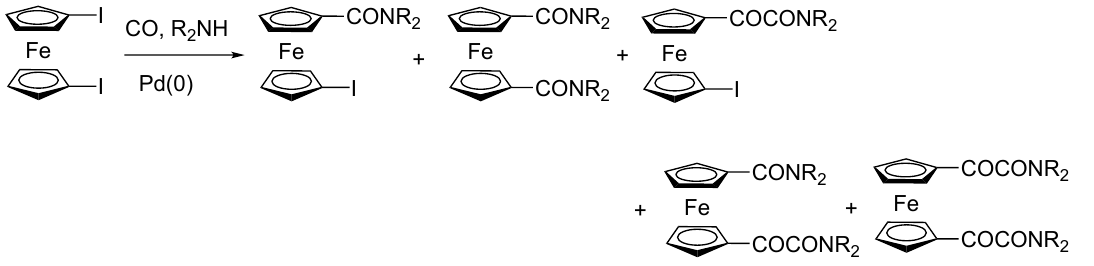
Figure 18. Aminocarbonylation of